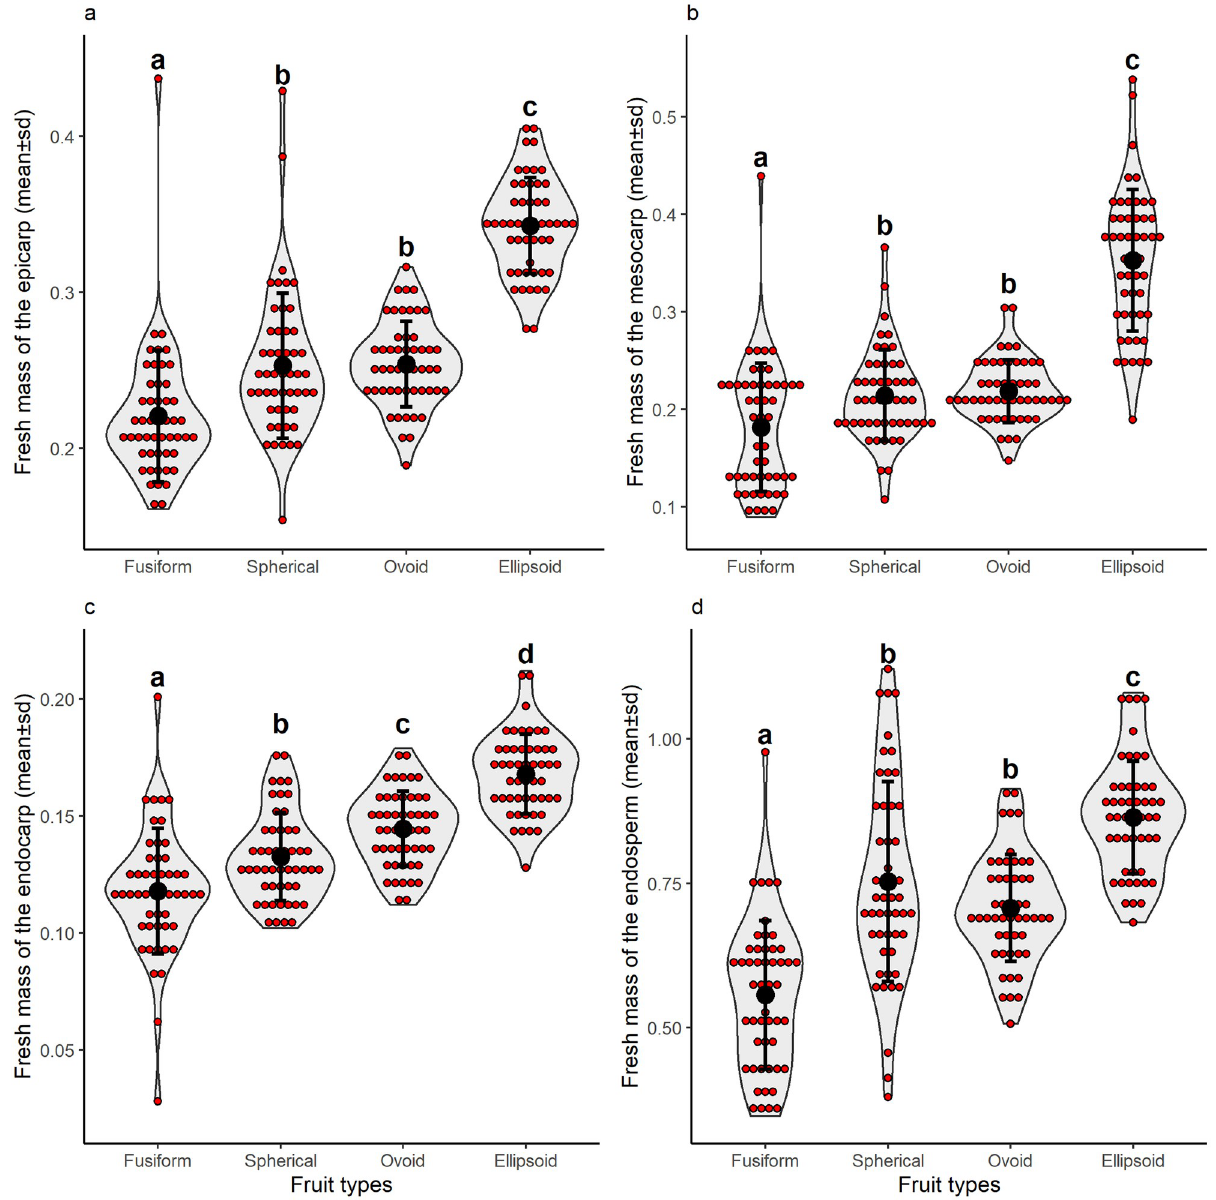
Fig 3. Yield of fresh masses of (a) exocarp, (b) mesocarp, (c) endocarp, and (d) endosperm of Copernicia alba fruits concerning phenotypes. Red dots after the mean and standard deviation represent the empirical data. The gray area is the density of the points distribution. Different letters for factor levels represent significant mean difference under Tukey’s